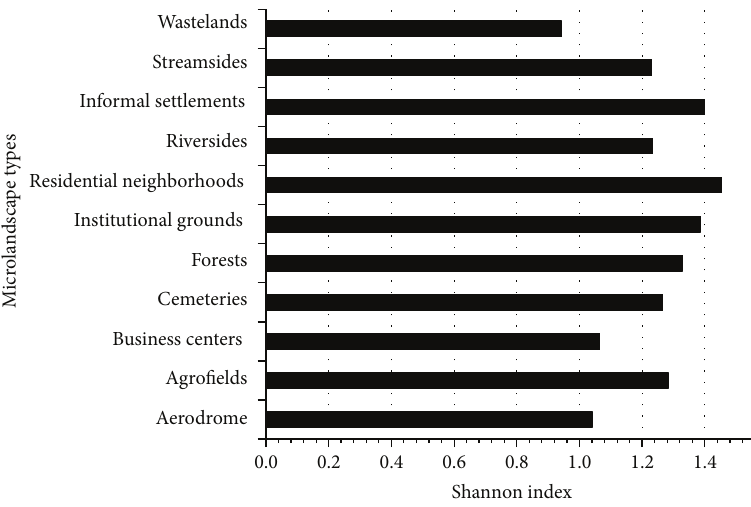
Figure 10: Shannon index for microlandscape types of Musanze